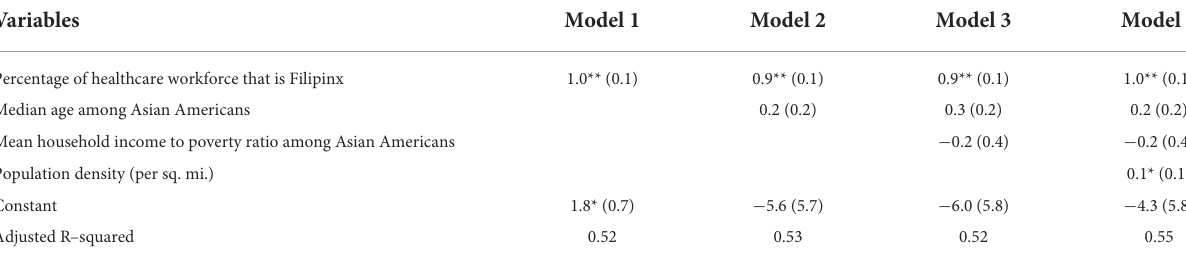
TABLE 3 Regression of percentage of COVID-19 decedents who are Asian Americans on percentage of healthcare workforce that is Filipinx in U.S. counties, n = 96.